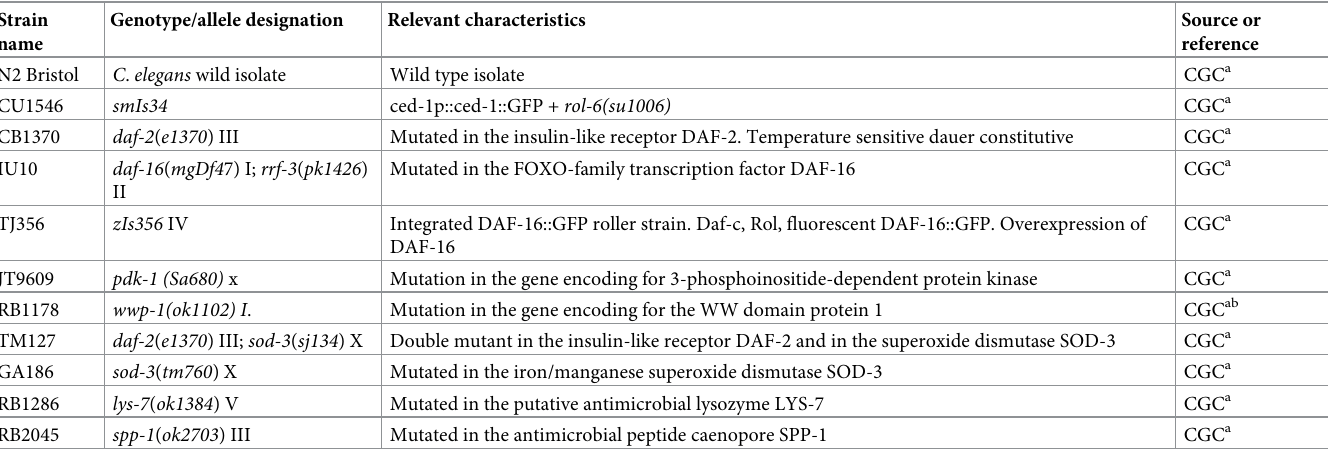
Table 2 is incorrect. Please see the corrected Table 2 here. Table 2. C . elegans strains used in this